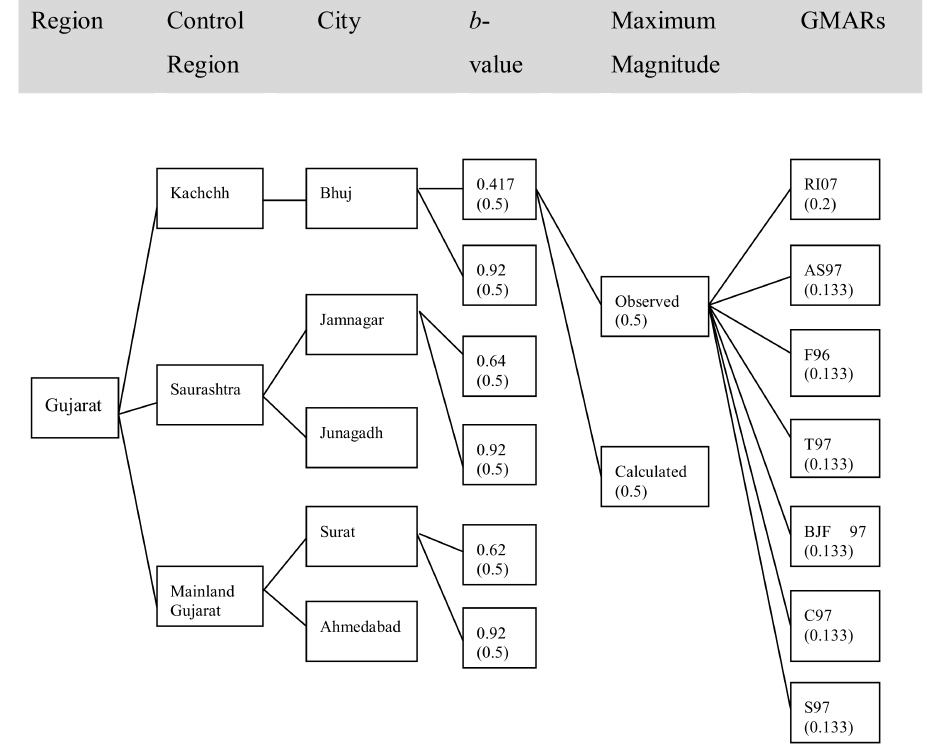
Fig. 8. Logic Tree used in seismic hazard computations (figures in the bracket show the weightage assigned in seismic hazard computations) (Abbreviations: Raghu Kanth and Iyengar (2007) – RI07, Abrahamson and Silva (1997)– AS97, Frankel (1996) – F96, Toro et al. (1997) – T97, Boore-Joyner and Fumel (1997) – BJF97, Campbell (1997) – C97, Sadigh et al. (1997)–